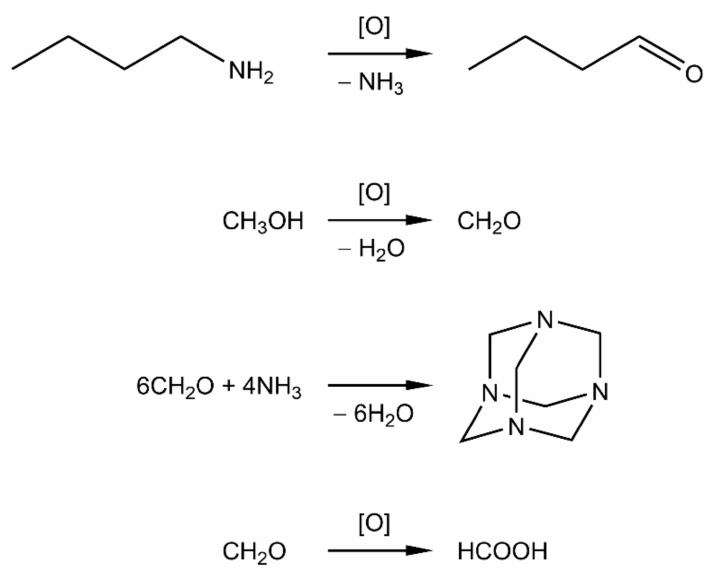
Figure 6. Supposed scheme of formation of the main products detected in the reaction solution during photocatalytic hydrogen evolution over HLT 3 × BuNH 2 /Pt from 1 mol. % aqueous